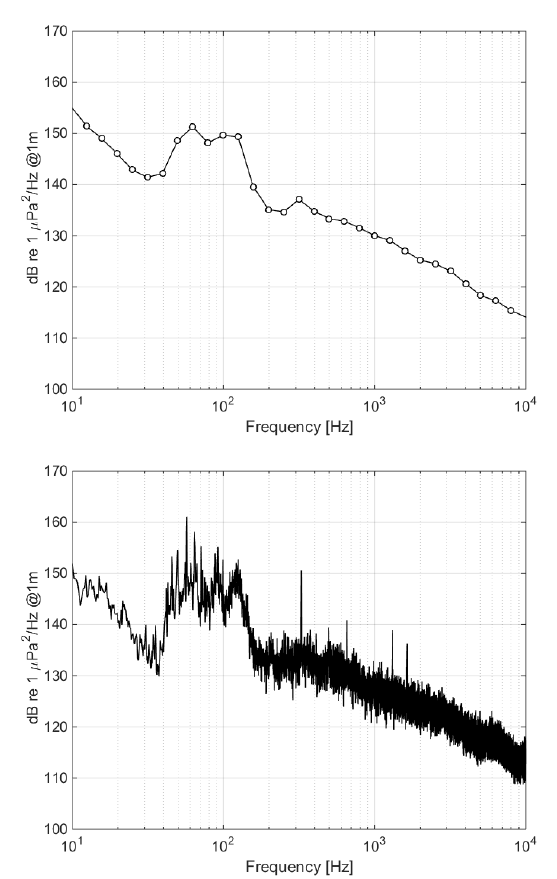
Figure 21: 1/3 octaves band levels (upper figure) and Narrow band spectrum (lower figure) for the underwater noise emitted by the vessel.